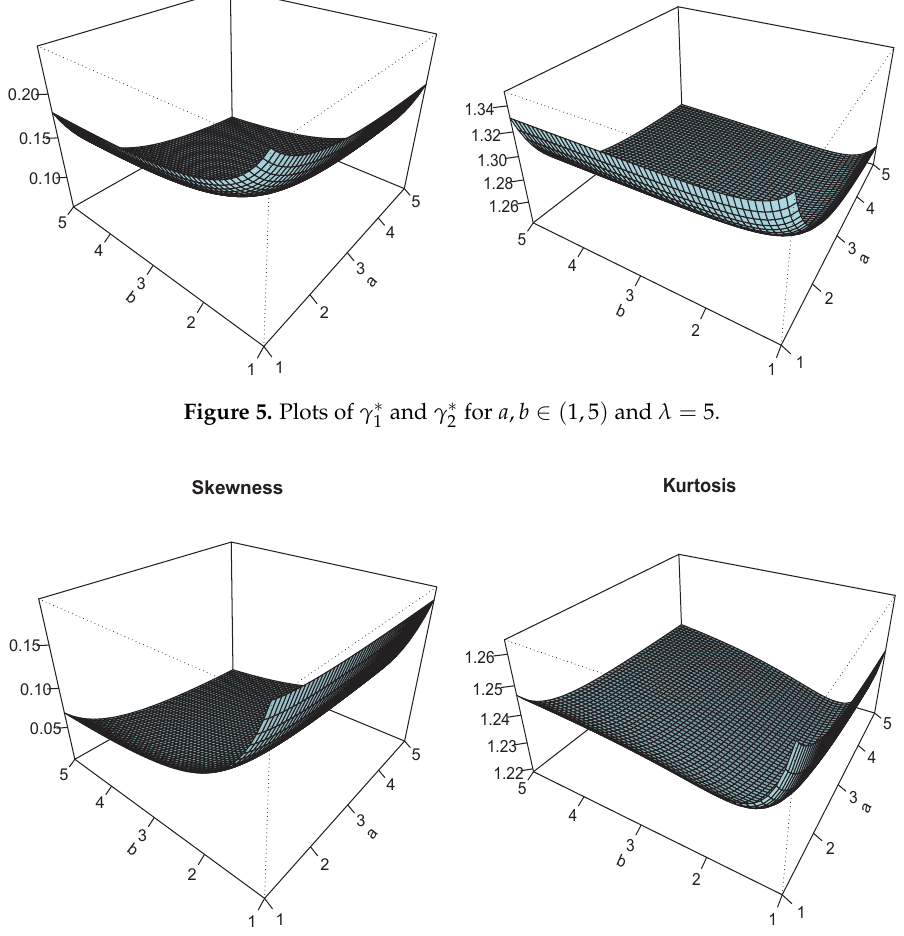
and γ ∗ for a , b ∈ ( 1,5 ) and λ = 20. 2 1